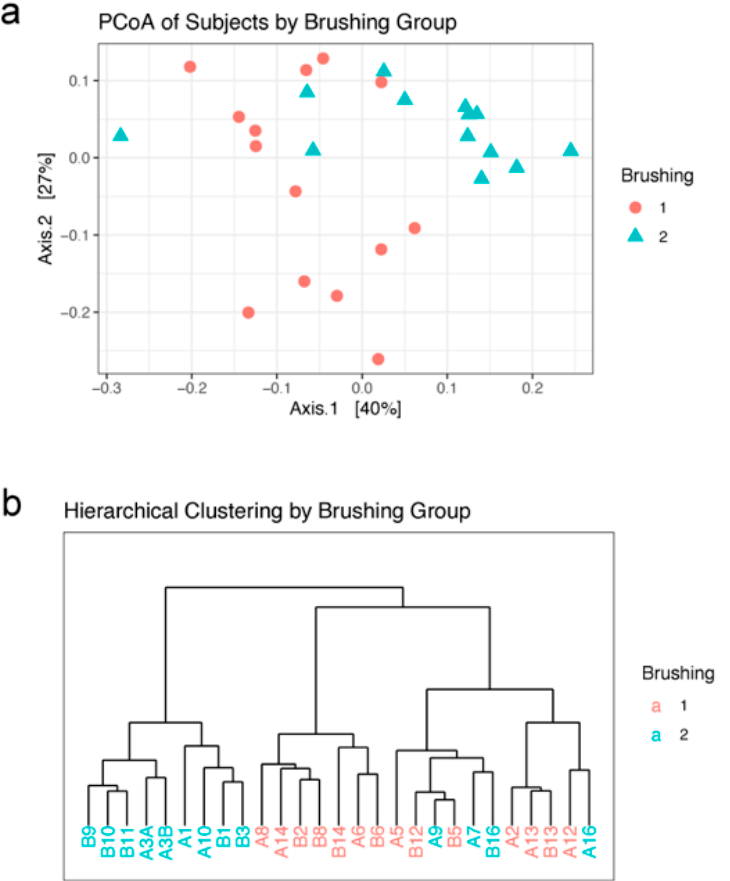
Figure 3. Beta diversity: ( a ) Ordination of the first two axes from principal coordinates analysis (PCoA) of subjects by brushing group. ( b ) Dendrogram of hierarchical clustering of subjects in each brushing group. Brushing groups: brush1: once a day (red); brush2: twice a day (blue).